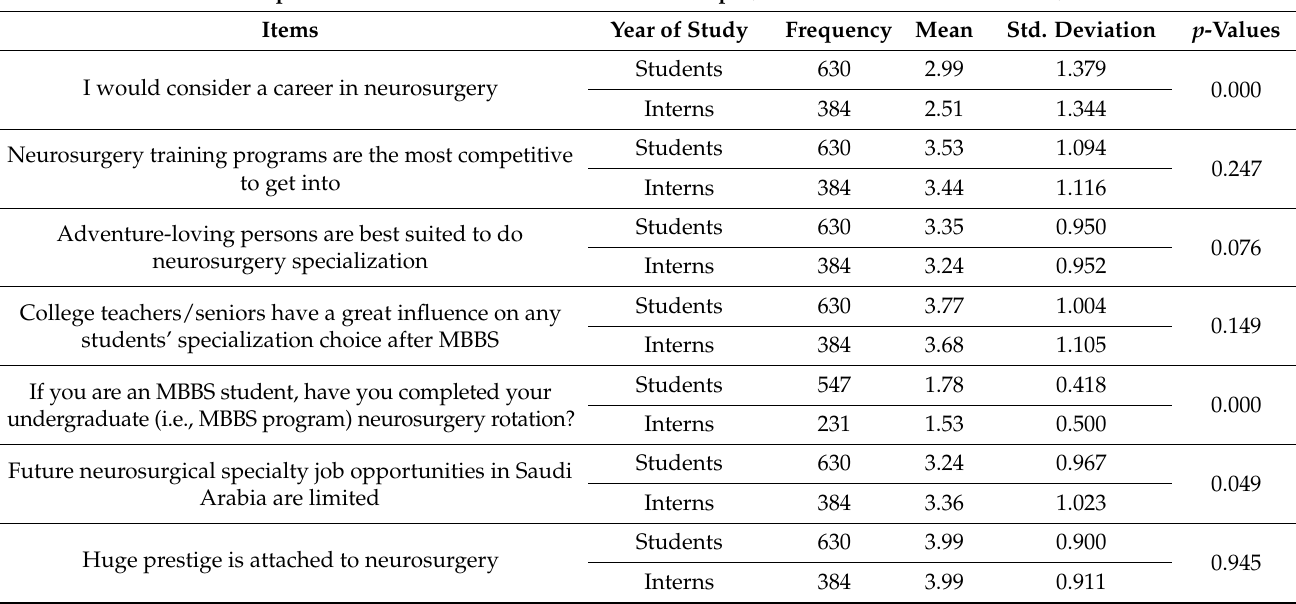
Table 3. Comparison of item responses between medical students and